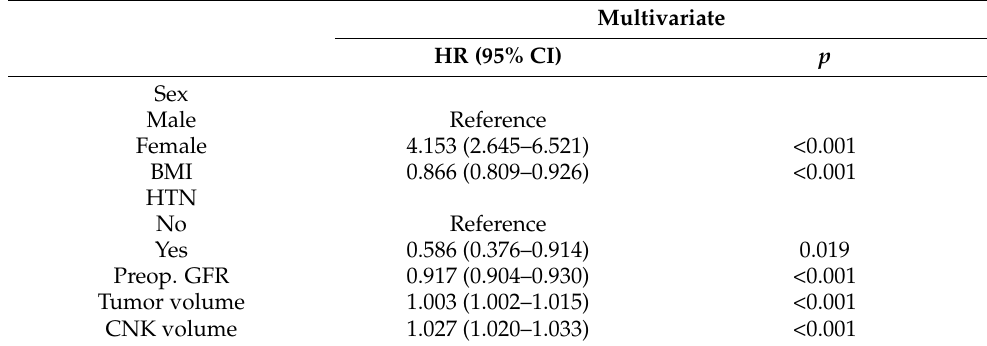
Table 2. Multivariate logistic regression analysis of factors associated with compensation from preoperative period to postoperative 1 week (process 1) in patients treated with radical nephrectomy for